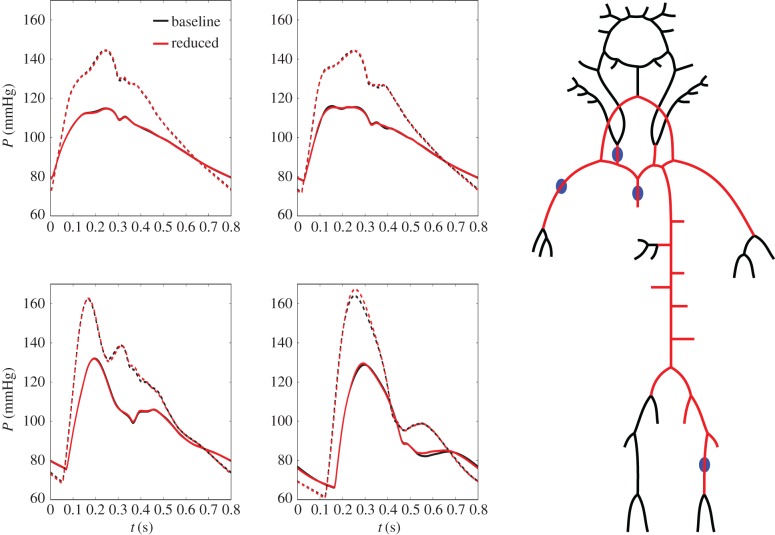
Optimal network obtained from the 96-artery baseline model with pressure at midpoint of ascending aorta (top left), right common carotid artery (top middle), right brachial artery (bottom left) and left femoral artery (middle bottom) set as quantities of interest. The average deviation at these four locations was used as threshold, and set to 0.4% average error. Dashed waveforms represent the case when baseline and reduced networks were re-parametrized to simulate normal ageing (see §2.6).